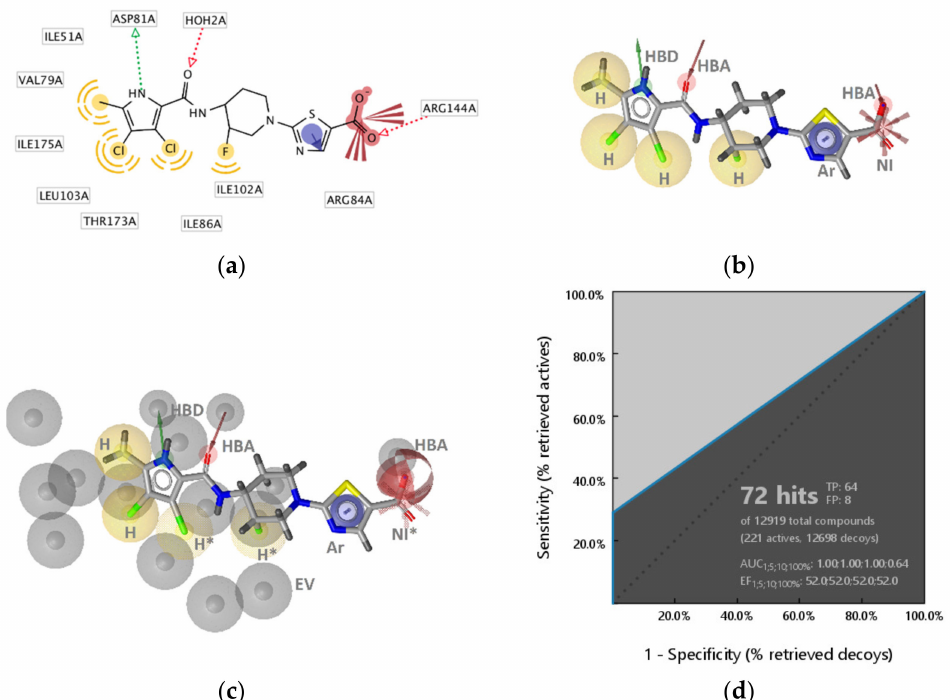
Figure 3. Structure-based binding interactions of a GyrB pyrrolamide inhibitor (PDB ID: 3TTZ) ( a ) 2D-depiction of interactions and the amino acid binding partners and ( b ) 3D-depiction of the SB-interaction model (binding site interactions displayed in Figure 2a); ( c ) SB-GyrB-Model-1 : re- fined structure-based GyrB inhibitor pharmacophore model based on a pyrrolamide inhibitor. The pharmacophore features are: hydrophobic (H, yellow spheres), aromatic (Ar, blue disc), hydrogen bond donor (HBD, green arrow), hydrogen bond acceptor (HBA, red arrow or sphere), negative ionizable (NI, red star). Exclusion volumes (EV, grey). Optional pharmacophore features are marked with *; ( d ) ROC plot (curve shown in blue) generated from virtually screening 12,919 compounds (221 GyrB actives and 1,2698 generated decoys) with the SB-GyrB-Model-1 . TP = true positives; FP = false positives; AUC = area under the curve; EF = enrichment